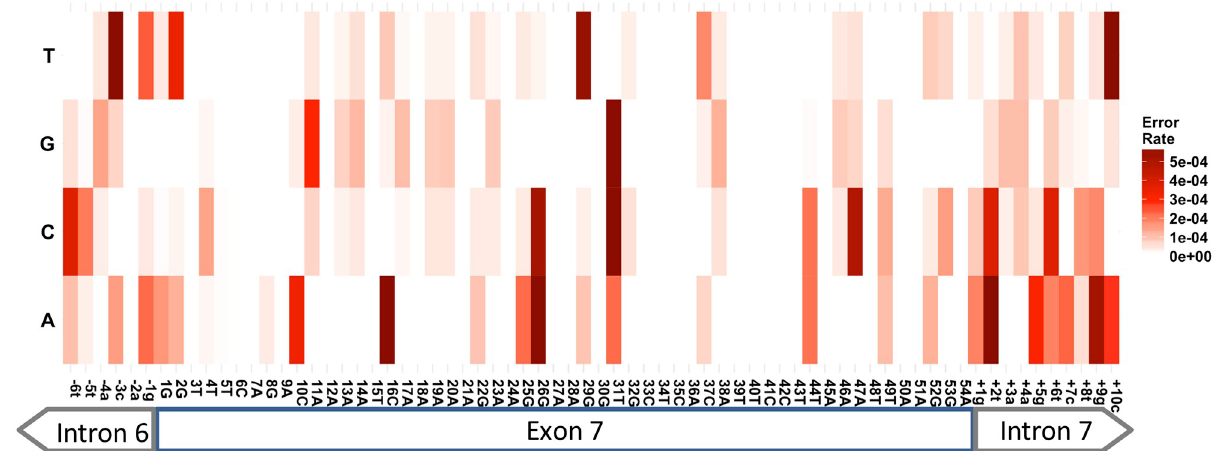
Fig 3. Mutation rate by position in DNA input reads. A heatmap representing positional error rates in DNA input reads that lie within the 15 nucleotide primers on either side of the amplified section that was sequenced (100 nucleotides total). Positions within exon 7 that were purposely mutated in our library construction were omitted and set to zero.